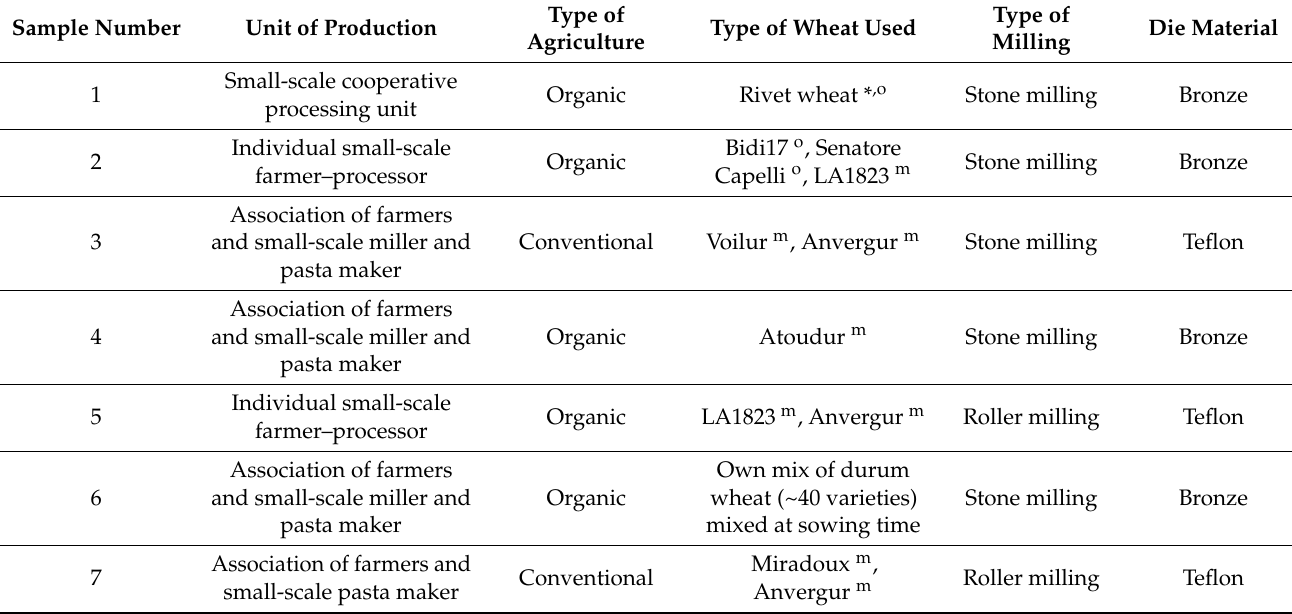
Table 1. Characteristics of the studied pasta